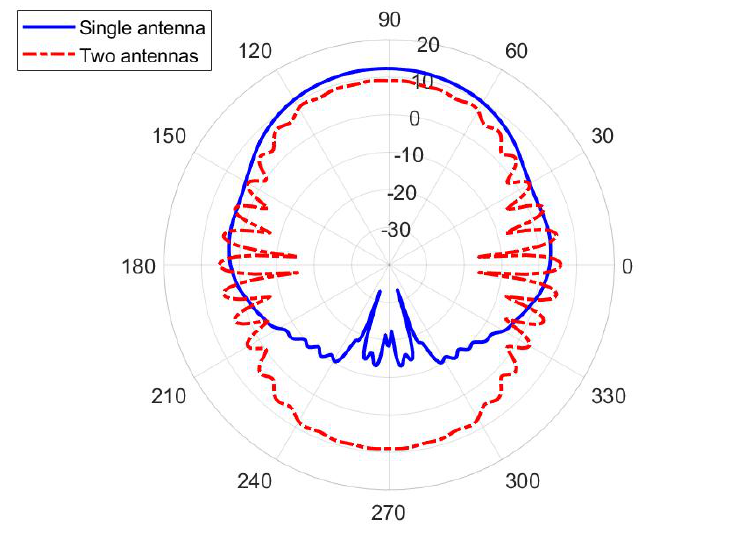
Figure 10. Radiation pattern in the E-plane ( xy -plane) of the textile slotted waveguide array placed vertically at the human phantom of the elliptical cross-section (Figure 9a). Both the cases of one and two slotted waveguide arrays (having excitation in phase) are shown. Radial scale is in dB, angular is in